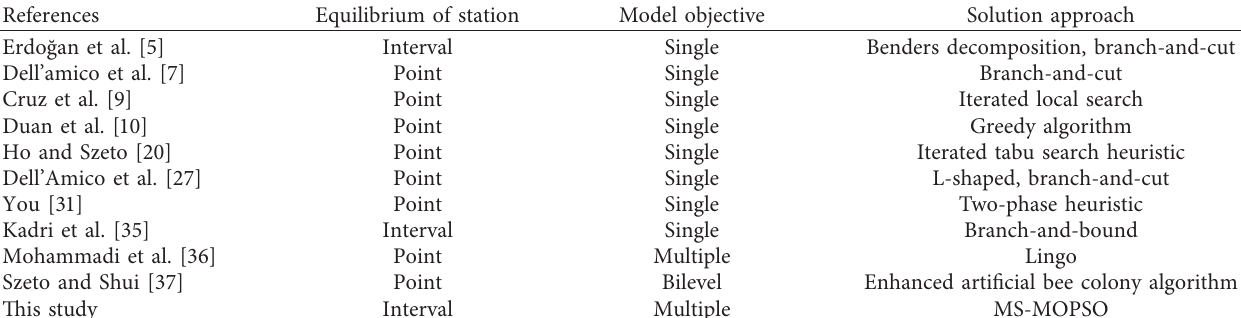
Table 1: Summary of the literature considering the equilibrium of station.